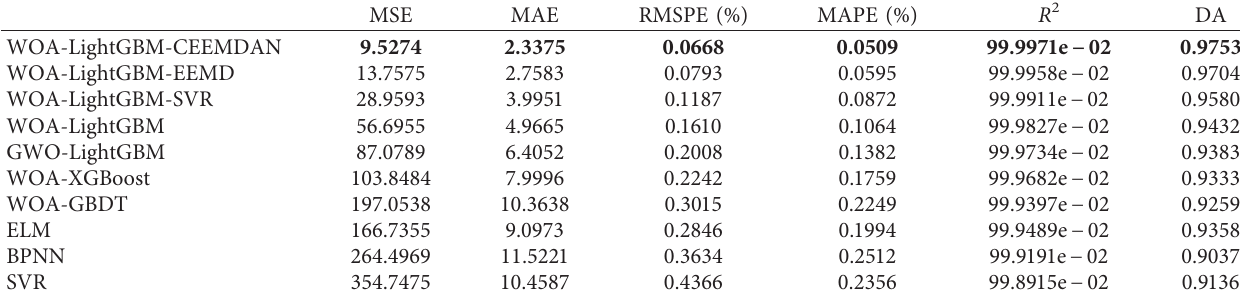
Table 8: Forecast accuracy table of CSI 300 stock index futures.